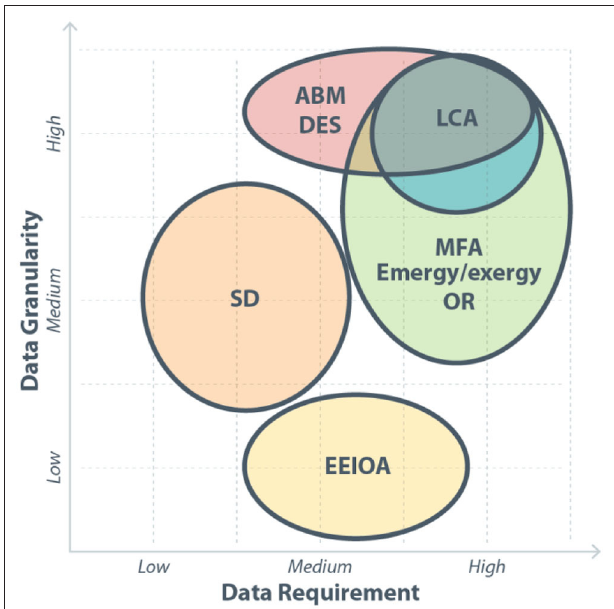
FIGURE 5 | Type and amount of data required by reviewed methods. Data requirement (the amount of data needed by the method) is correlated to the data granularity (the level of precision of the data used by the method). ABM, agent-based modeling; SD, system dynamics; MFA, material flow analysis; EEIOA, environmentally extended input-output analysis; LCA, life cycle assessment; OR, operations research; DES, discrete event